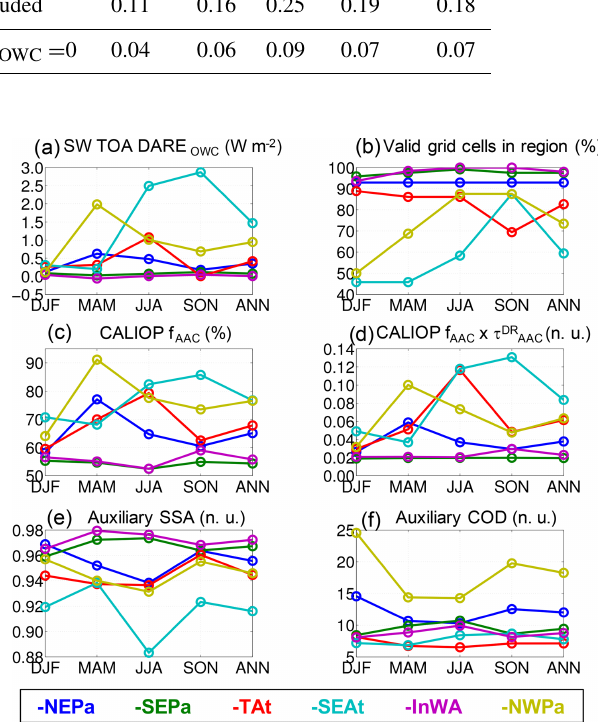
Figure 7. Mean regional, seasonal or annual (a) estimated SW TOA DARE OWC (Wm − 2 , calculation is described in Sect. 2.2), (b) per- centage of grid cells that show valid f AAC × τ DR (i.e., positive) AAC values compared to the total number of 4 ◦ × 5 ◦ pixels in each region, (c) CALIOP f AAC (%), (d) f AAC × τ DR (no unit), (e) assumed AAC overlying SSA at 546.3nm from a combination of MODIS–OMI– CALIOP and (f) assumed underlying COD from MODIS in each region of Table 5. DARE OWC in (a) is computed using the Case IV of Table